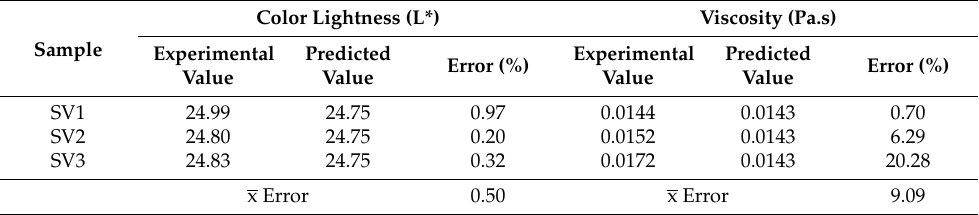
Table 7. Experimental validation for mangosteen-leaves-based marker ink